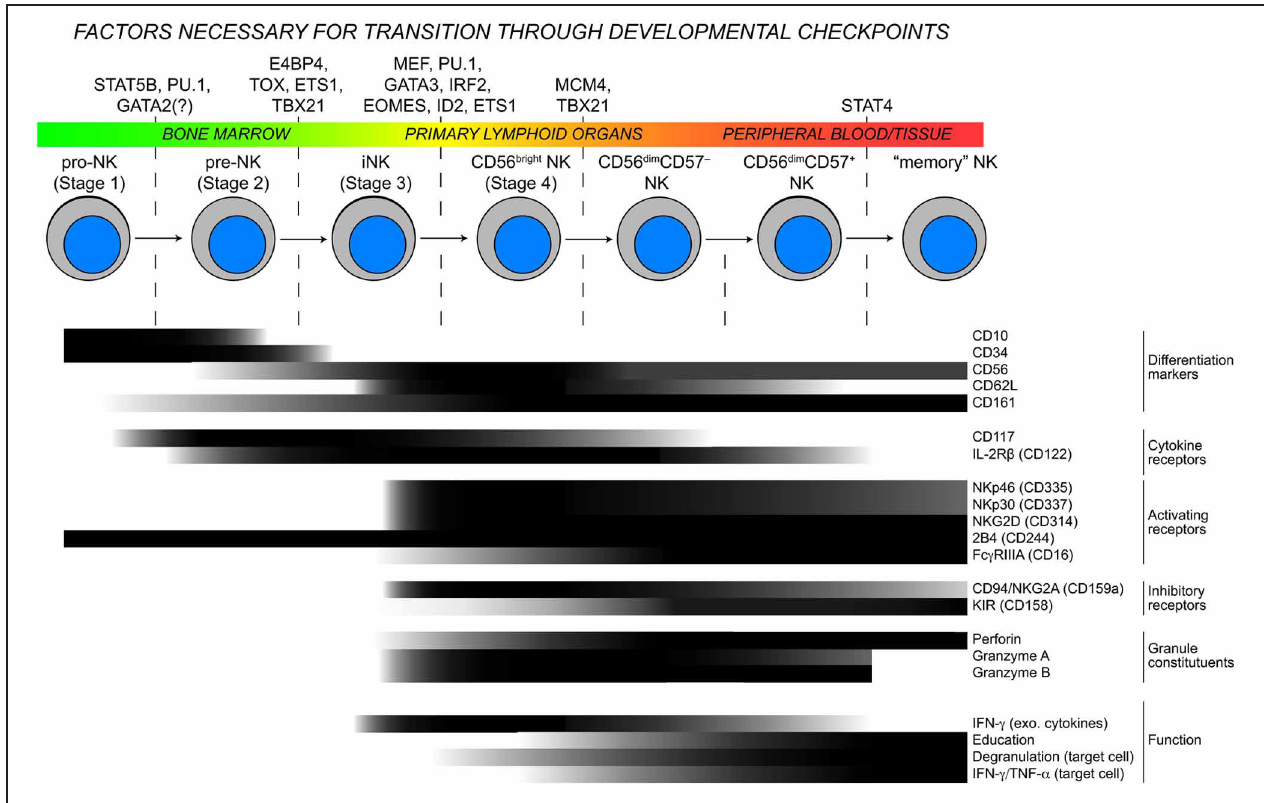
FIGURE 1 | Checkpoints in NK cell development. As NK cells develop, they transit through the body and advance through checkpoints that are controlled by DNA-binding factors. Throughout this process, the expression of developmental markers, cytokine receptors, natural cytotoxicity receptors,